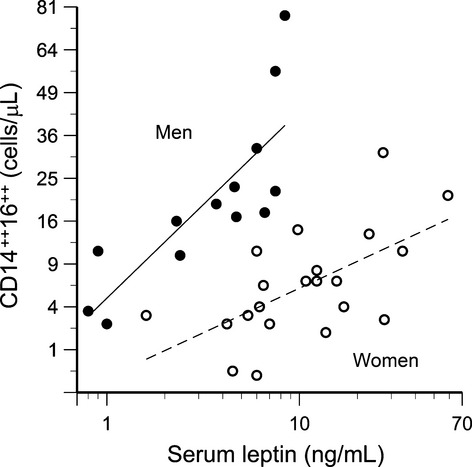
Circulating CD14++16++ monocytes correlate with serum leptin concentrations (P < 0.0001) in a sex‐specific manner (leptin × sex interaction P < 0.05). Mean CD14++16++ counts were significantly higher for men than women (P < 0.0001), and exhibited a stronger correlation with serum leptin (R = 0.80, P = 0.0009) than for women (R = 0.60, P = 0.005).